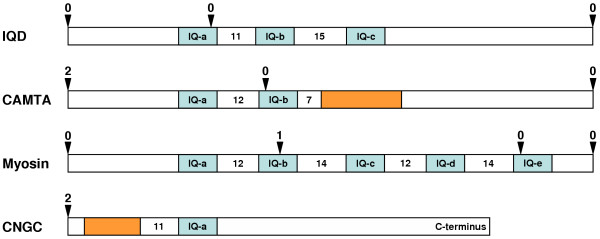
Organization of IQ motifs in major families of calmodulin-binding proteins. The scheme depicts the arrangement of the multiple IQ motifs present in proteins of the IQD family (this study; [37]), the CAMTA family of calmodulin-binding transcriptional activators [59-61], the myosin family [58], and the CNGC family of cyclic nucleotide gated channels [57, 104]. The IQ motifs are shown as light-blue boxes. Predicted and experimentally verified calmodulin-interacting peptide sequences are shown in orange. The numbers in the white spacers equal the number of separating amino acid residues. The triangles and numbers above each protein family model indicate the position and the phase of conserved introns, respectively. The positions of the left and right most introns are not drawn to scale.